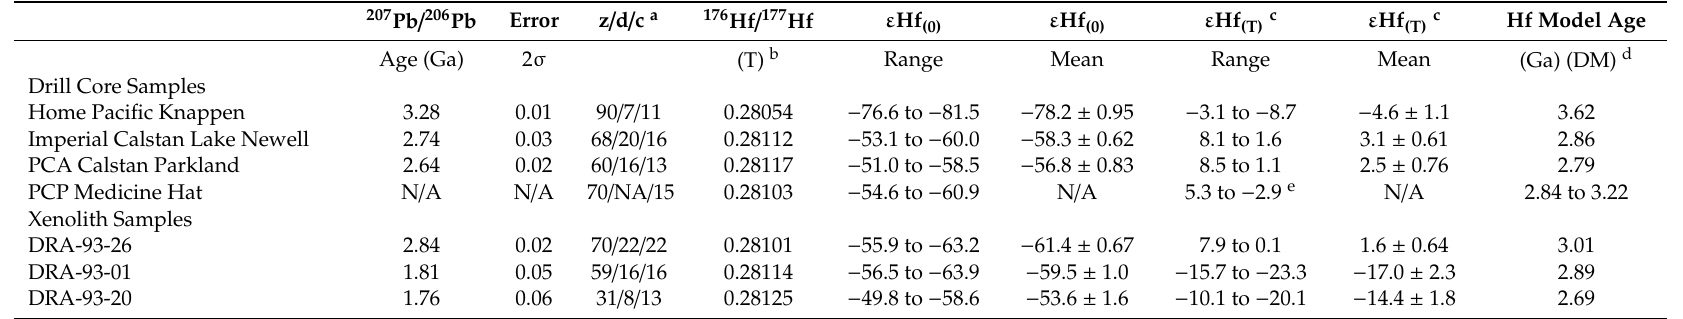
Table 2. LA-ICP-MS data. 207 Pb / 206 Pb ages and Lu–Hf-isotope data